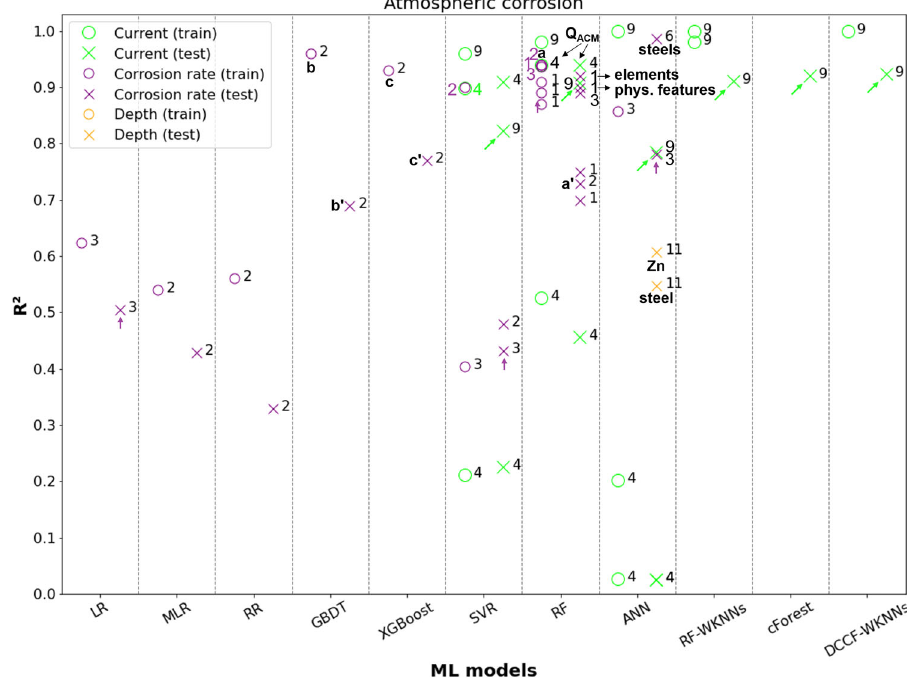
Fig. 7 Performance of the ML models expressed by R² applied to atmospheric corrosion (refs. 1 – 4,6,9,11 ). Data points were segmented by ‘ Targets ’ (current I, CR, depth) and by ‘ ML models ’ . R² values are distinguished for the training ( ‘ O ’ ) and testing ( ‘ X ’ ) performances. Meaningful entries from the following features were included in the plot: the ‘ Material ’ (Zn, steel 11 , steels 6 ); the ‘ Selected features ’ (elements, phys. features 1 ). Q ACM indicates the RF with charge correction 4 . The purple and green arrows, respectively, indicate the data points from refs. 3 and 9 (modelling on the same dataset). The difference between values a, b, c and a ′ , b ′ , c ′ highlights a low generalisation ability 2